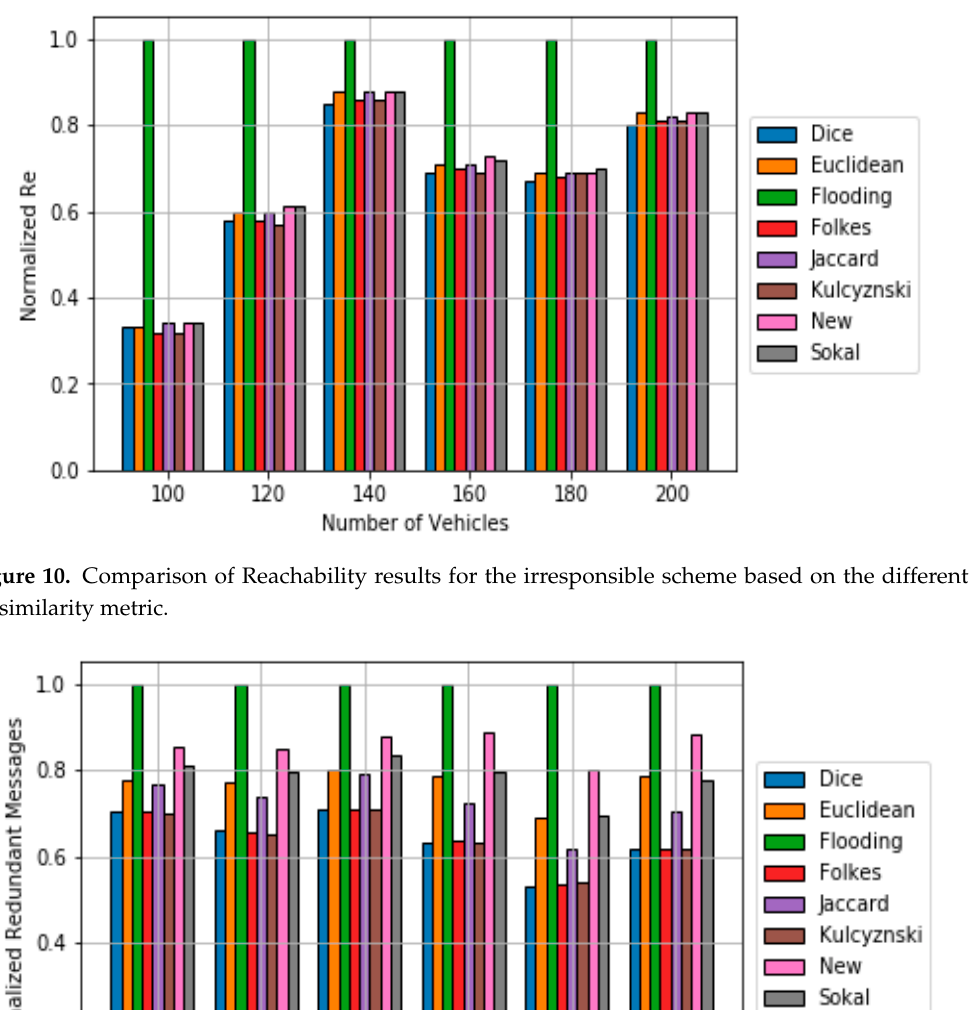
Algorithm 4. Irresponsible algorithm based on dissimilarity metric.